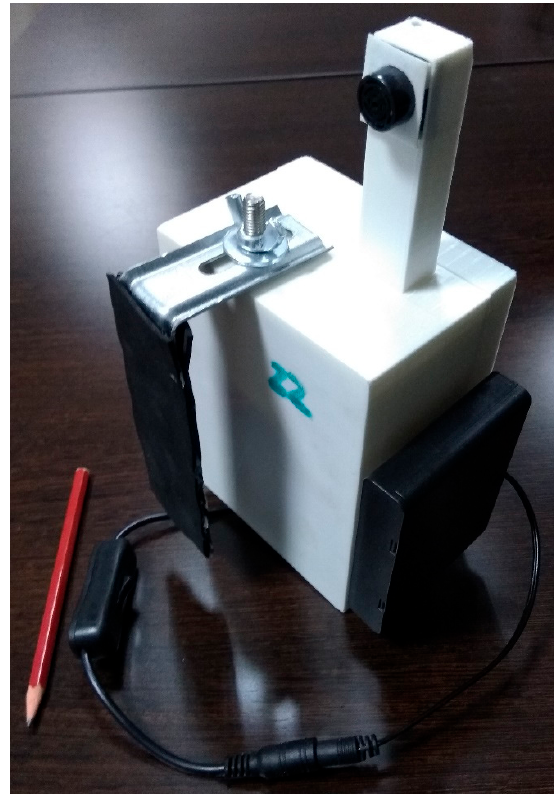
Figure 3. External casing for the chair–stand sensor. The sensor can be attached to chairs with very different designs thanks to a hook of adjustable width. The ultrasound sensor towers above like a